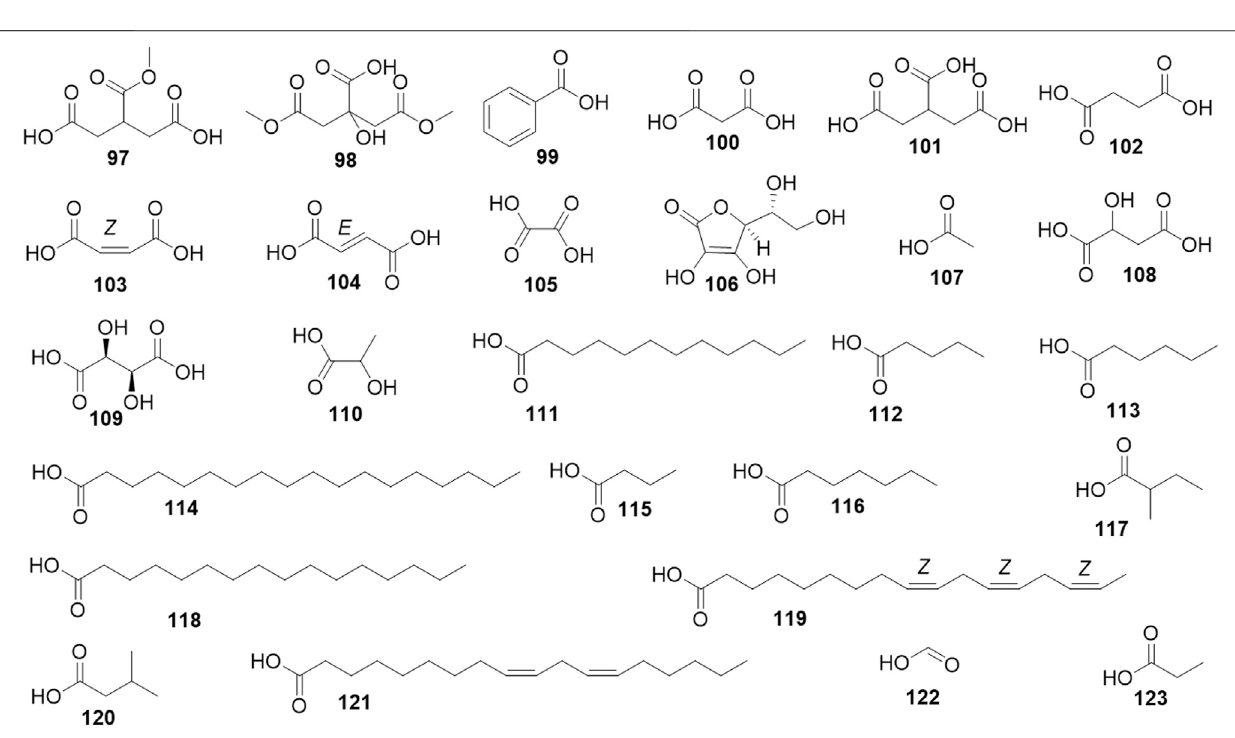
FIGURE 5 | Structures of the Organic acid derivatives (97 – 123) form P. mume